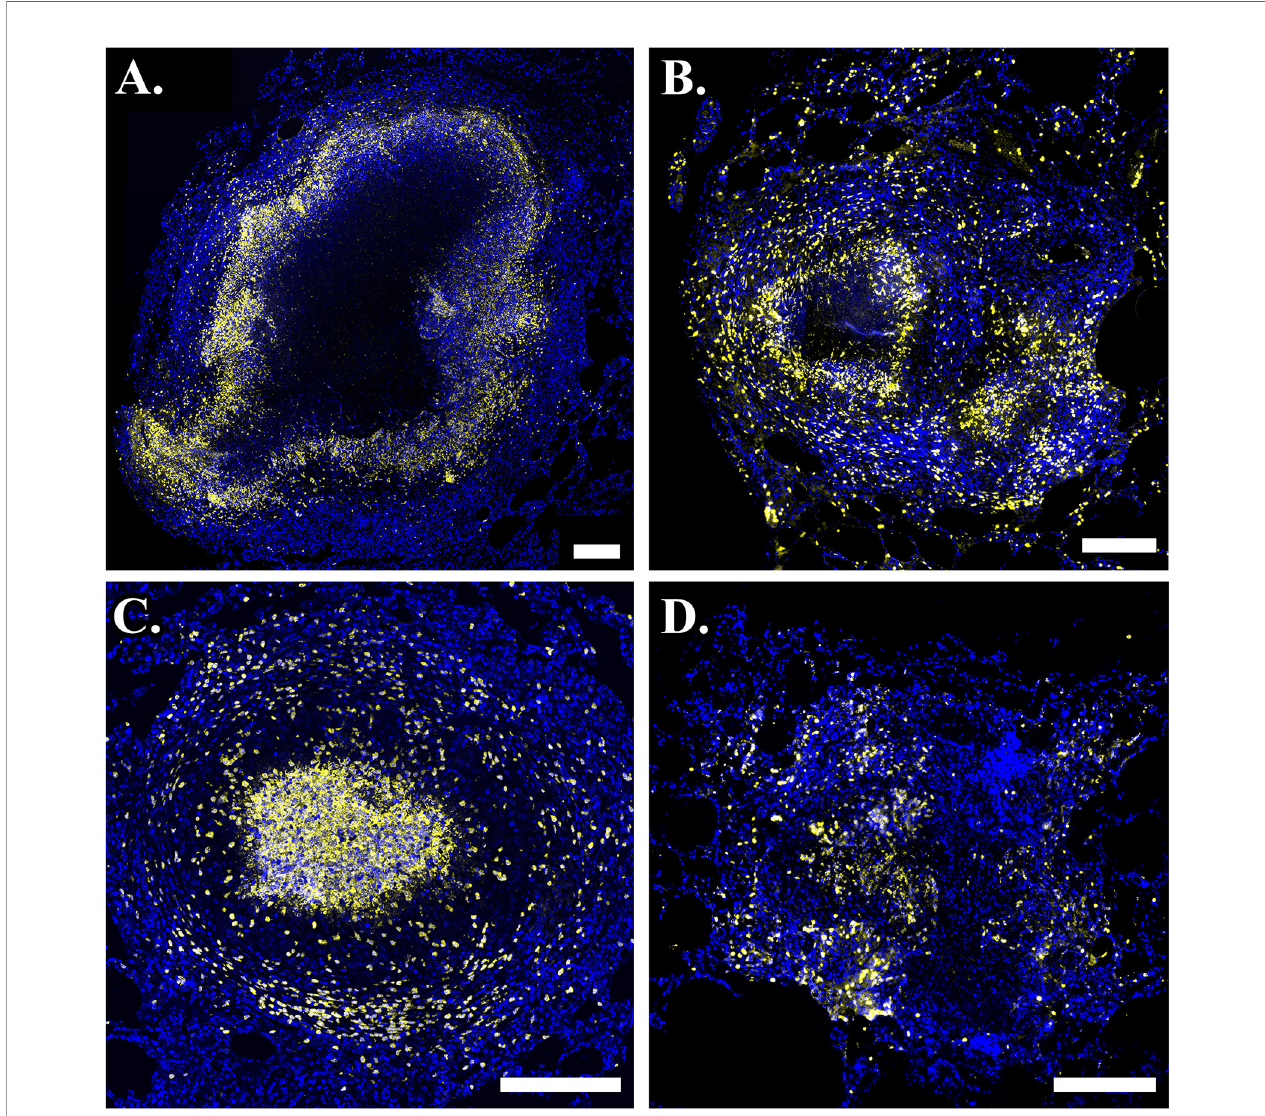
FIGURE 2 | Neutrophils are present in phenotypically-diverse macaque granulomas. Representative granulomas showing (A) a necrotic granuloma with a large central region of caseum, (B) a granuloma with two necrotic foci on the left and right sides of the granuloma, (C) a suppurative granuloma with large numbers of neutrophils in fi ltrating into the central region, and (D) a non-necrotic granuloma. Calprotectin- (S100A9) positive neutrophils are indicated in yellow and DAPI-stained nuclei are indicated in blue. Scale bar represents 250